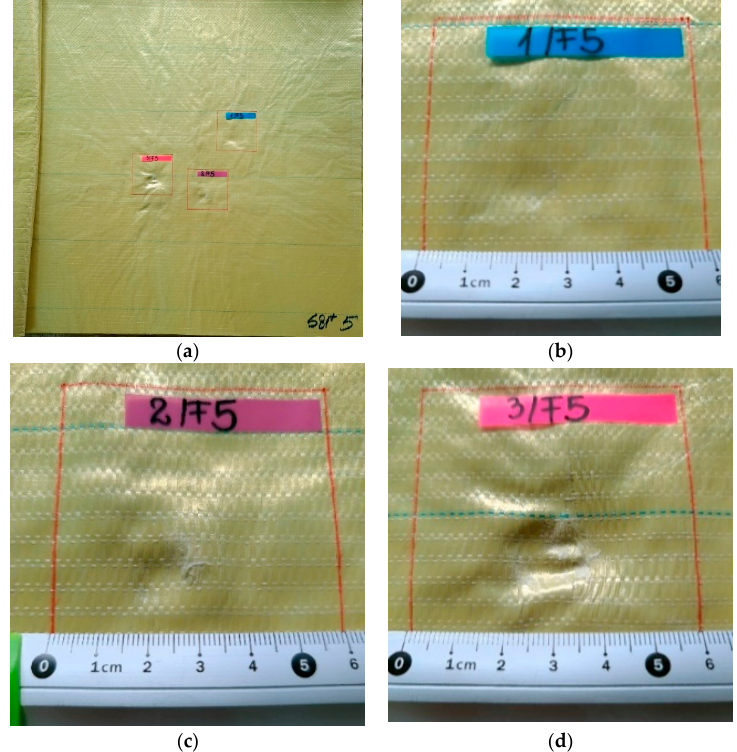
Figure 11. Frontal view of a package made of layers of LFT SB1plus: ( a ) layer 5 (face), with details of ( b ) fire 1, ( c ) fire 2 and ( d ) fire 3. Figure 12 presents the last layer of the package: (a) the general view being taken from the opposite direction of the impact (named back face in this text), (b) the print on the last layer of fire 1, where aramid fibers are not broken, only the auxiliary (white) yarns that keep the resistant aramid yarns in their aligned position, (c) for fire 2 the yarns are not broken but (d) for the last fire, there are several bundles of fibers broken due to the large deformation on this layer.